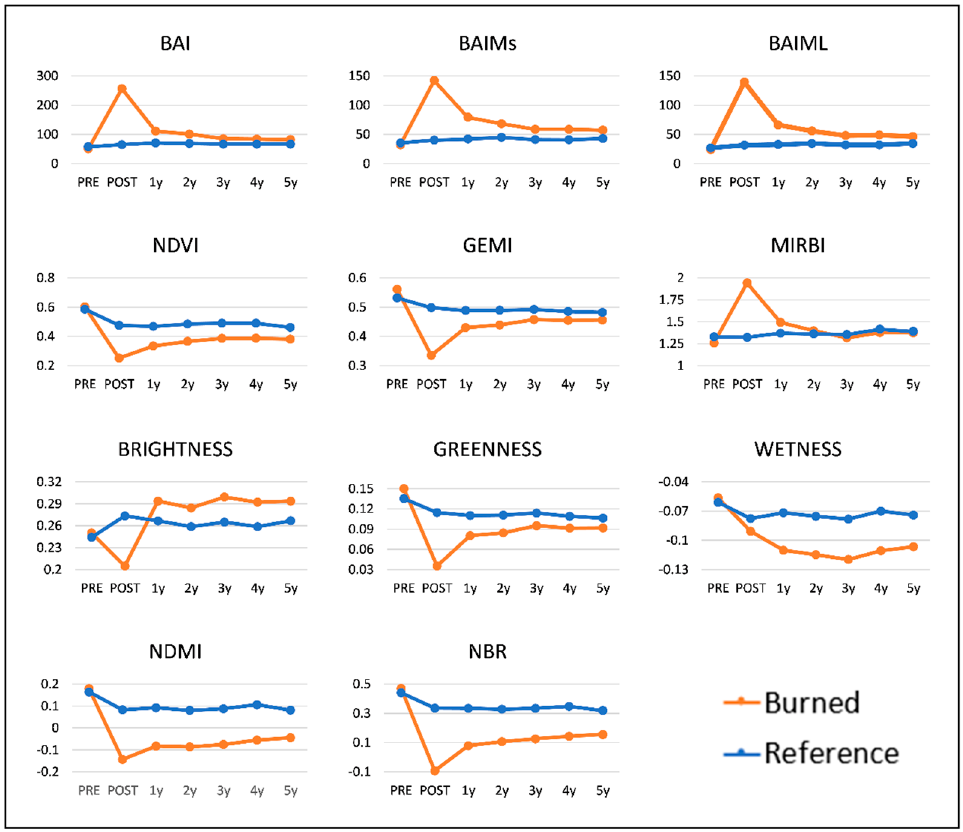
Figure 4. Spectral Indices’ trajectories over time: pre- and post-fire, and 1, 2, 3, 4, and 5 years following the fire. The plots represent the SI mean values for the burned and the reference samples of the whole dataset. Table 3. Separability index ( M -statistic) and Residual Severity Ratio ( RSR ) for the 11 SI. Highlighted cells indicate the three best performers at the given post-fire time in the following rank/color order: 1st, 2nd, 3rd. Pre-fire M -statistic values are shown as reference. MS = maximum severity from which RSR is calculated. Negative values of RSR indicate that the trajectory of the burned class crossed the trajectory of the unburned control class.